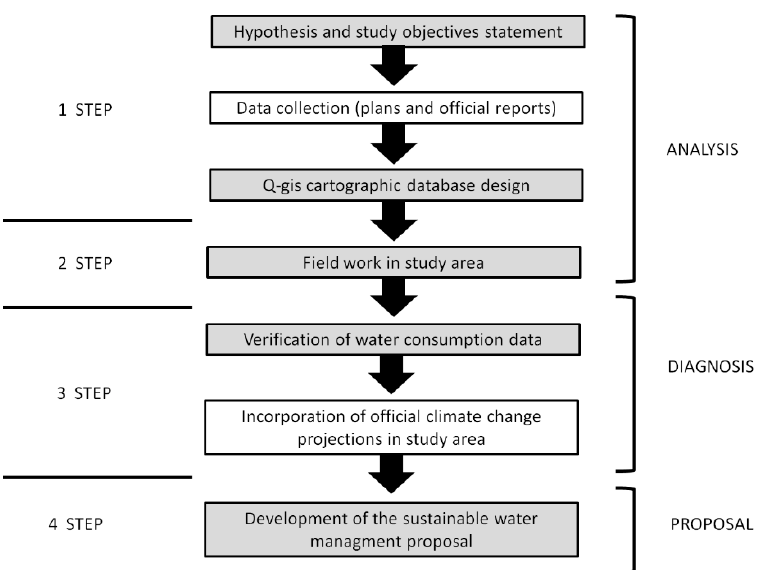
Figure 3. Diagram/outline of the methodological steps in this paper.Source: own elaboration. The innovative contributions of this paper are shown in the shaded areas.